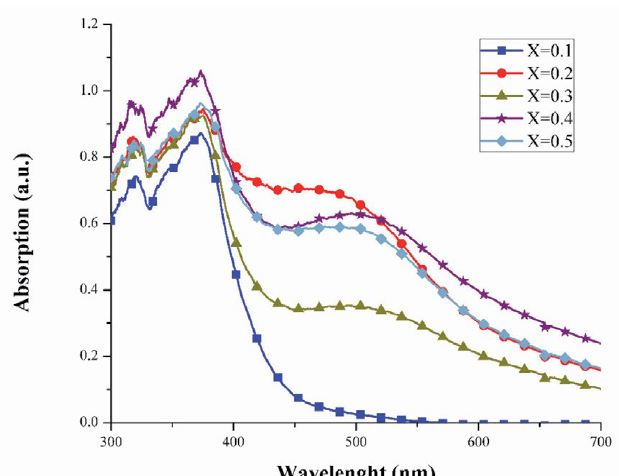
Fig. 3. UV-visible absorption spectra of the Cd Fig. 3 UV-visible absorption spectra of the Cd x Zn 1-x O composites with different compositions.